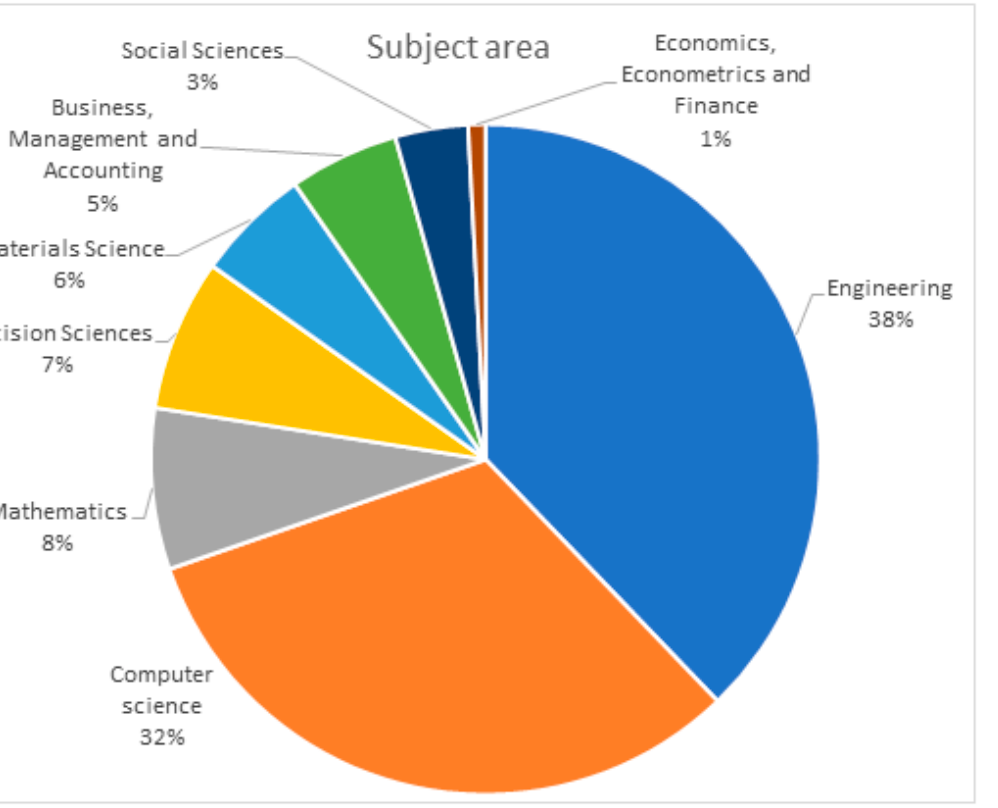
Figure 12. Subject areas in which Maintenance 4.0 papers were the most frequently published (for the Scopus database).